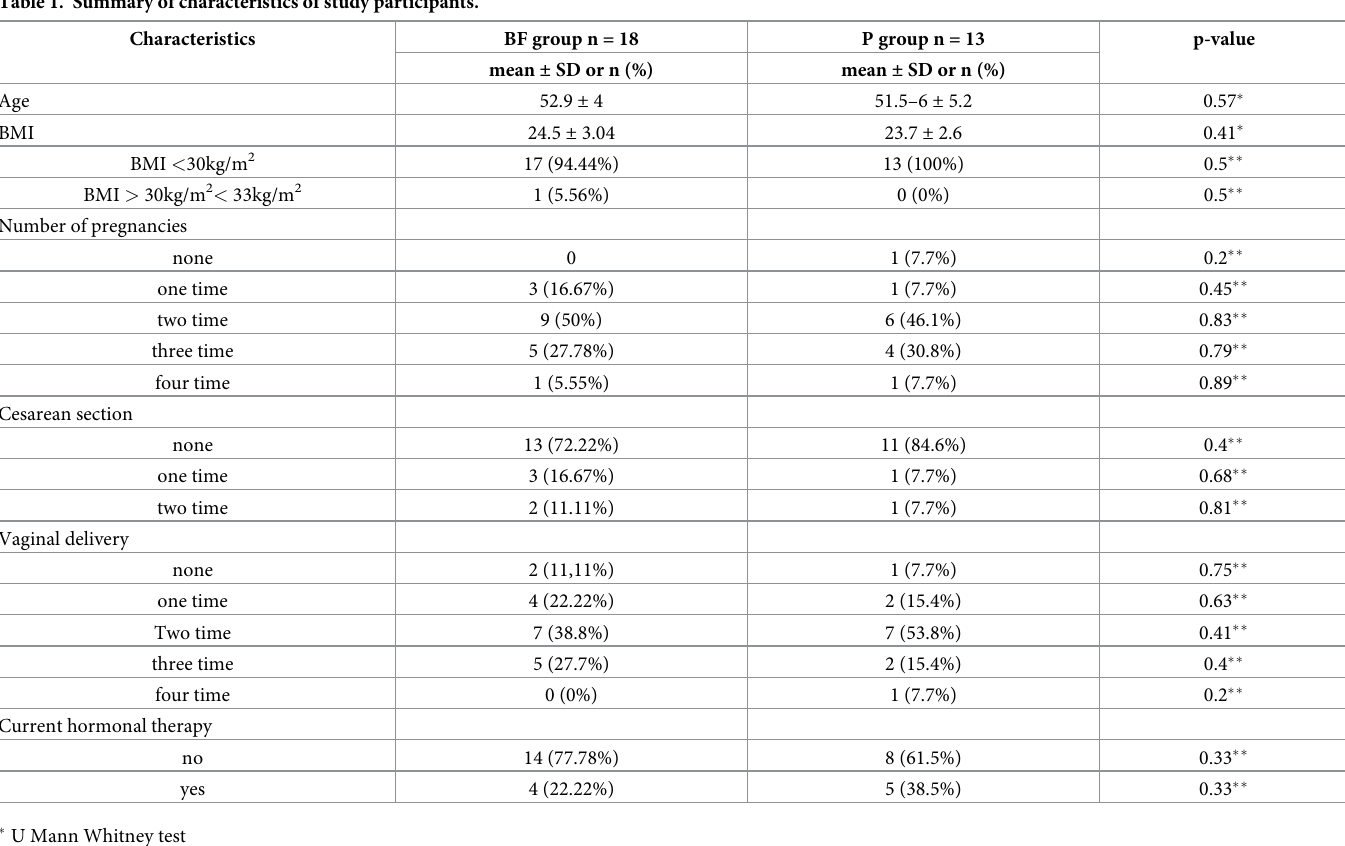
Table 1. Summary of characteristics of study participants.